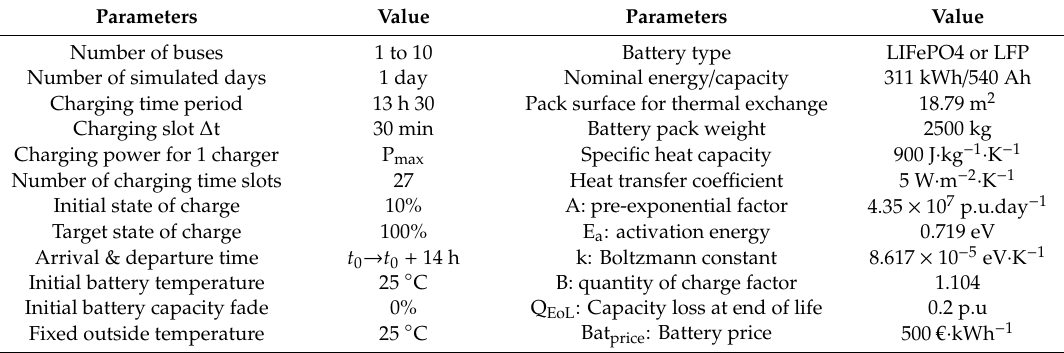
Table 1. Simulation parameters input, operating constraints and electro-thermal-aging battery